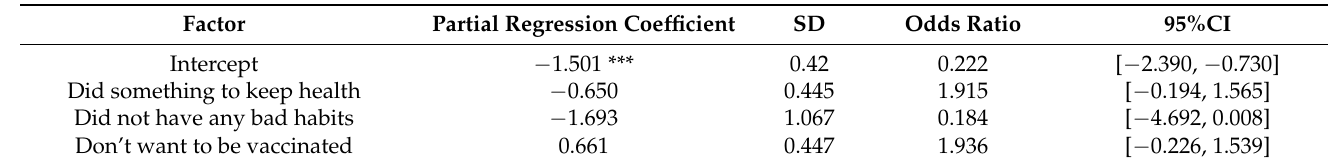
Table 8. Binormal regression of the responses to the question “Has the pandemic changed your self-assessment of health status?” (Niigata girls).